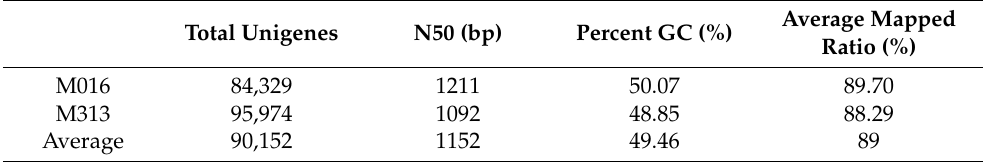
Table 1. Summary of de novo assembled